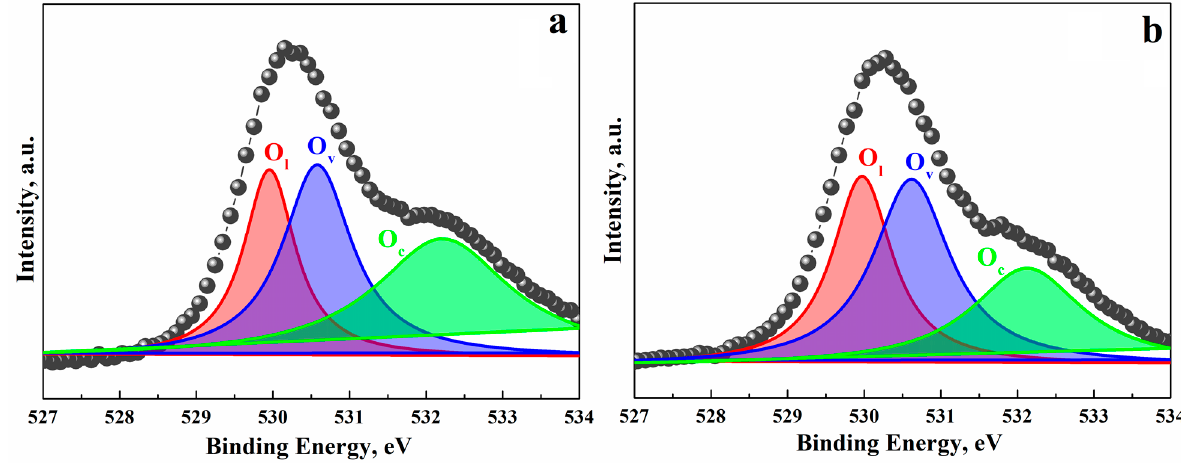
Figure 9. XPS spectra of O 1s (black circles) in In 2 O 3 ( a ) and in the composite 3%CeO 2 –97%In 2 O 3 ( b